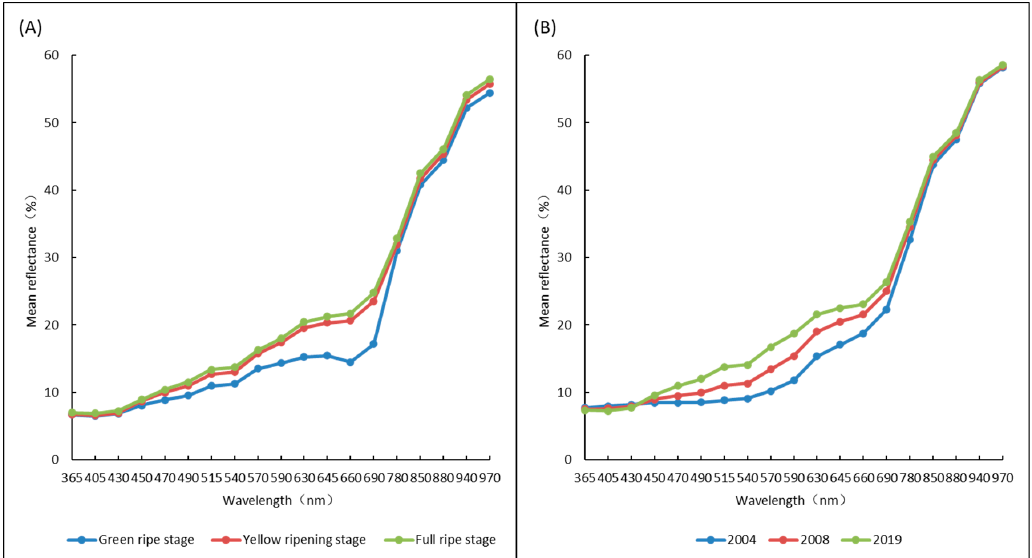
Figure 4. Mean spectral reflectance of alfalfa seeds at ( A ) different maturity levels and ( B ) harvest years.